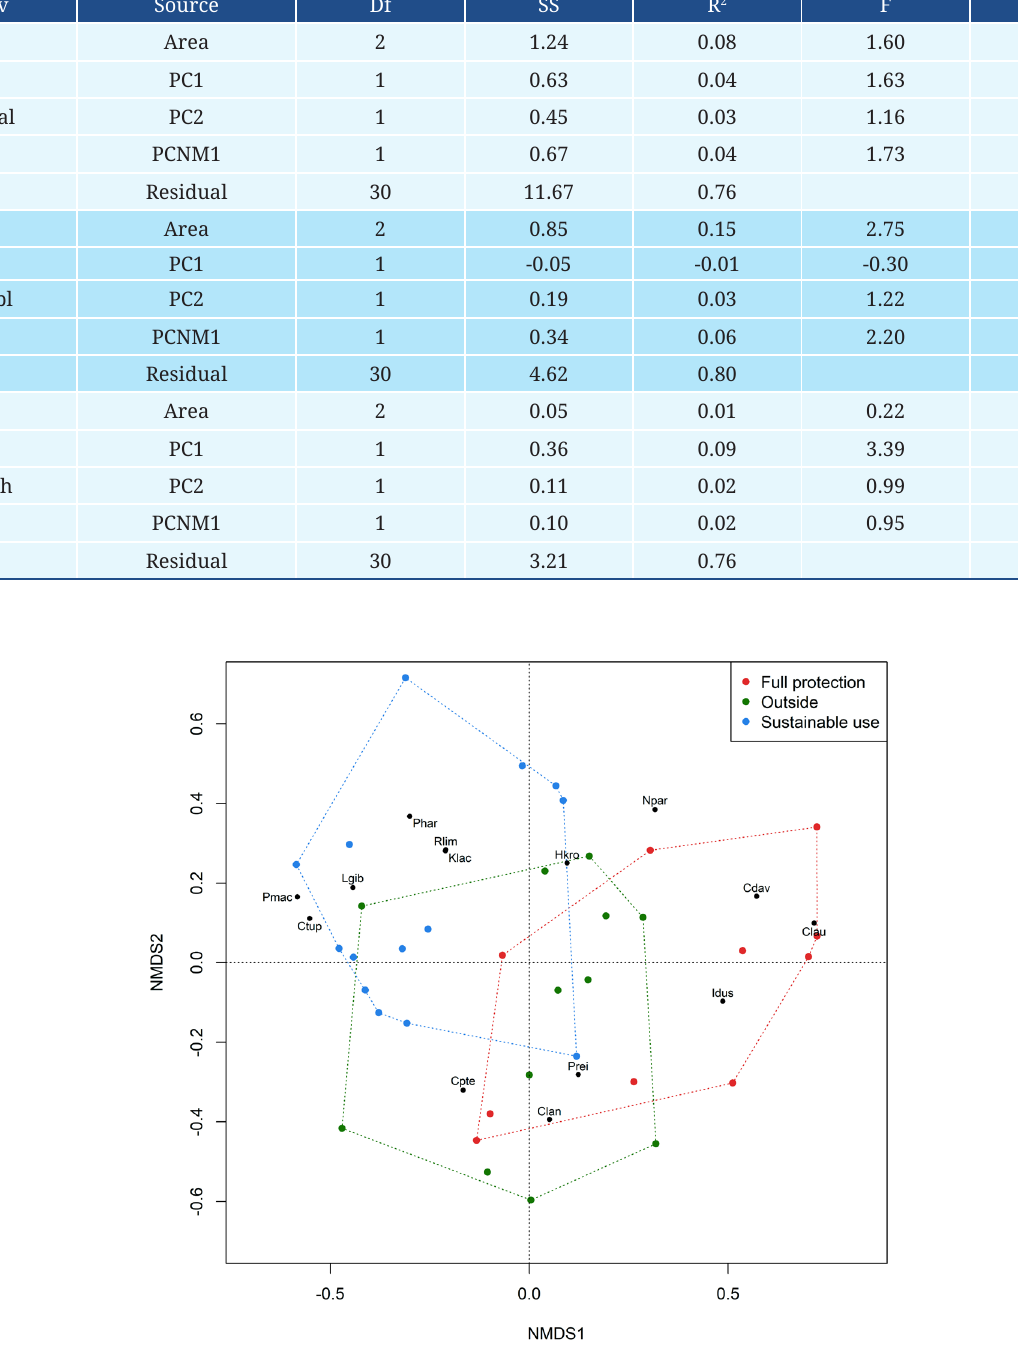
FIGURE 3 | NMDS biplot of the fish abundance data (Hellinger- transformed and Euclidean distance matrix). Stress = 0.20. The 30% most frequent species with 50% best axis fit were added using weighted averages. Species identification with code is in Tab. 1.